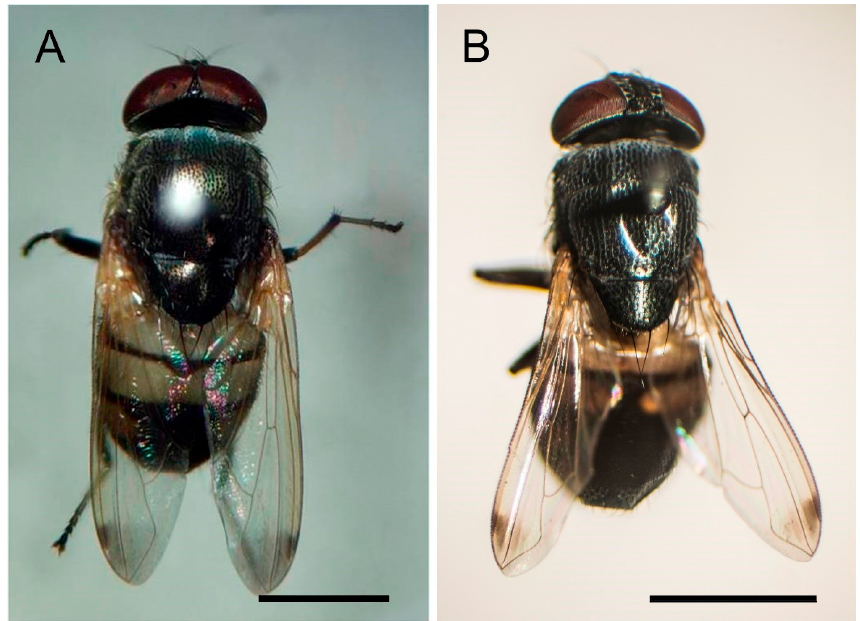
Figure 1. Dorsal view of Stomorhina discolor . ( A ) Male with holoptic eyes; ( B ) Female with dichoptic eyes (bar = 2 mm).